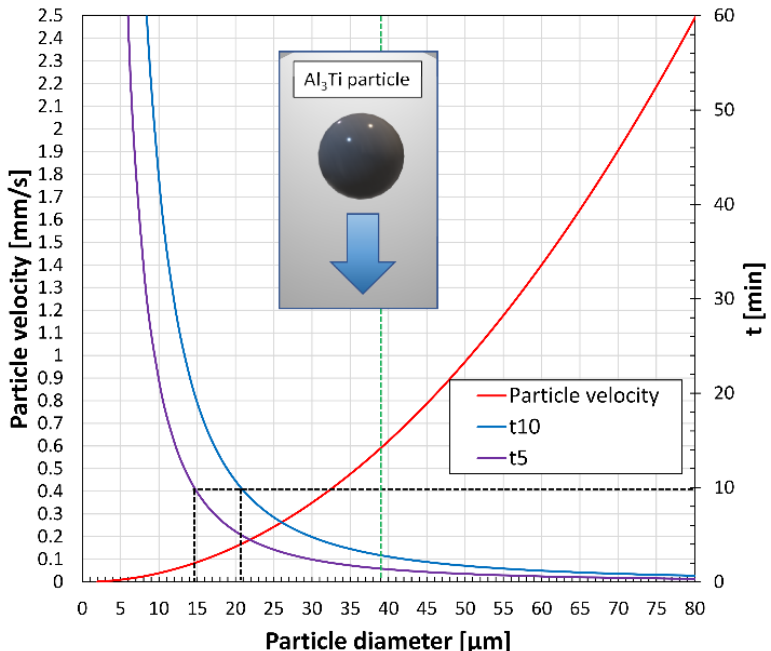
Figure 6. Terminal particle settling velocity values and the time needed to settle 5 and 10 cm as a function of the diameter of spherical Al 3 Ti particles.